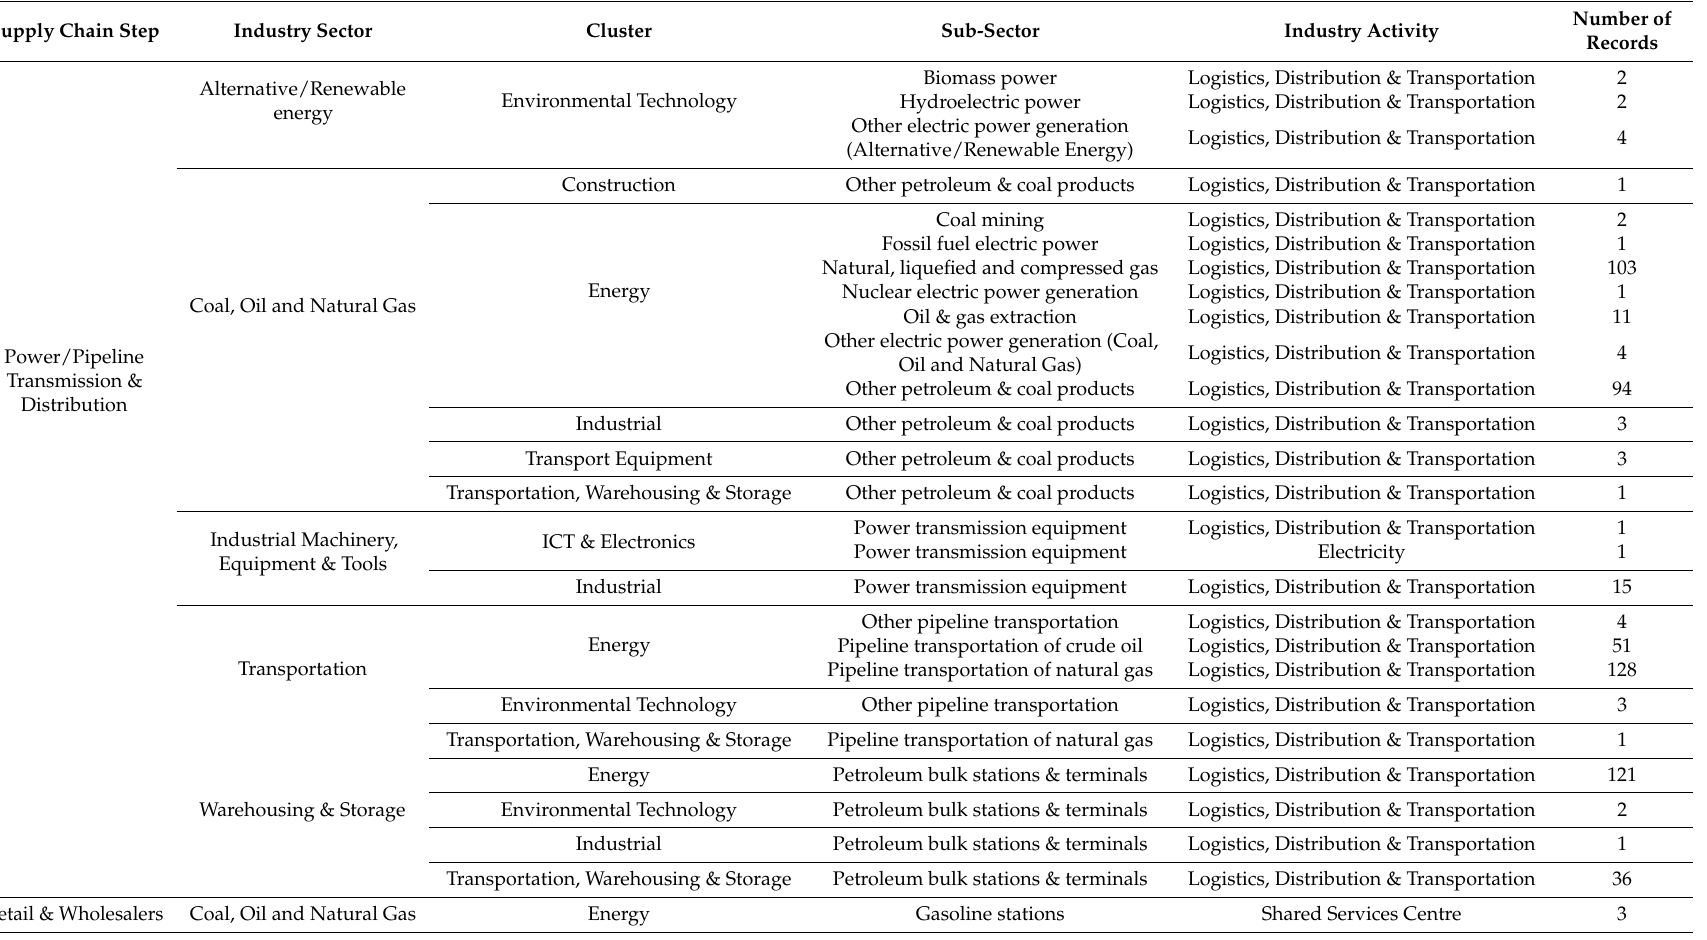
Table A3. Definitions for FDI Database: FDI Markets; Power/Pipeline Transmission & Distribution, Retail &